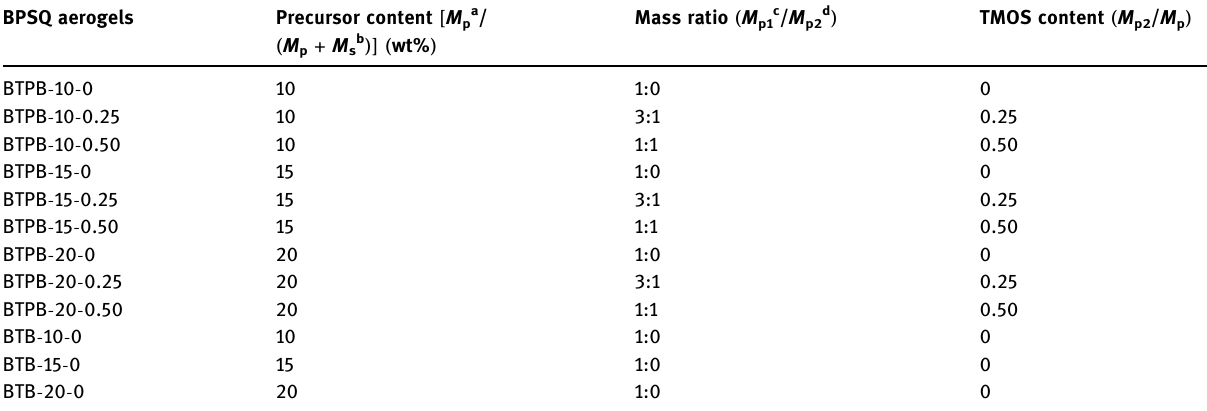
Table 1: Formulations of the BPSQ aerogels BPSQ aerogels